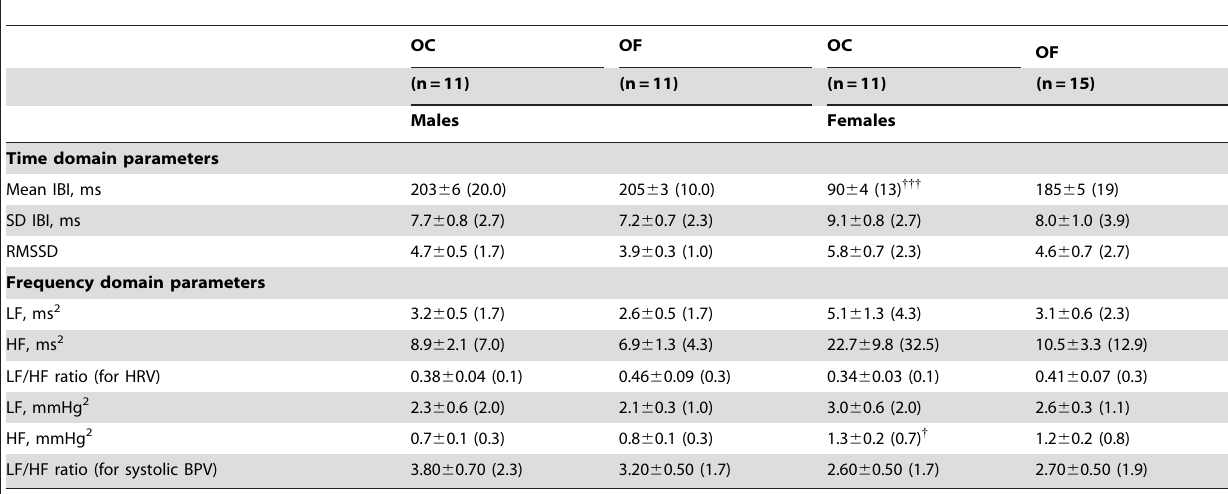
Table 3. Heart rate and blood pressure variability parameters in adult offspring born to dams fed a control (OC) or a fat diet (OF).